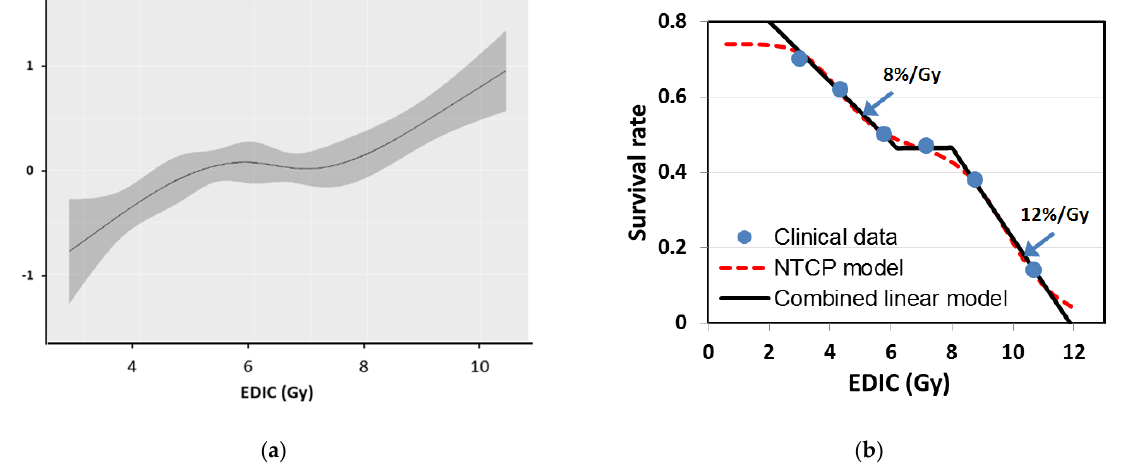
Figure 2. Quantitative effect of the effective dose to immune cells (EDIC) on the risk of death. ( a ) Relationship between relative hazard of death and the EDIC. The hazard of death increased with increasing EDIC when EDIC values was < 5.5 Gy and remained relatively unchanged when EDIC values ranged 5.5 to 7.5 Gy, and again increased with EDIC values > 7.5 Gy. ( b ) Relationship between 2 year overall survival (OS) rate and the EDIC by a normal tissue complication probability (NTCP) survival model. The clinical data were well fitted by the NTCP model composed of two components, with D50 being 4.5 and 9.9 Gy, respectively. The clinical data could also be described by a combined linear model with 3 parts: (1) for an EDIC < 6.0 Gy, 2 year OS decreased with increasing EDIC at a slope of 8%/Gy; (2) for an EDIC between 6.0 and 8.0 Gy, 2 year OS remained unchanged; and (3) for an EDIC > 8.0 Gy, 2 year OS decreased with increasing EDIC at a slope of